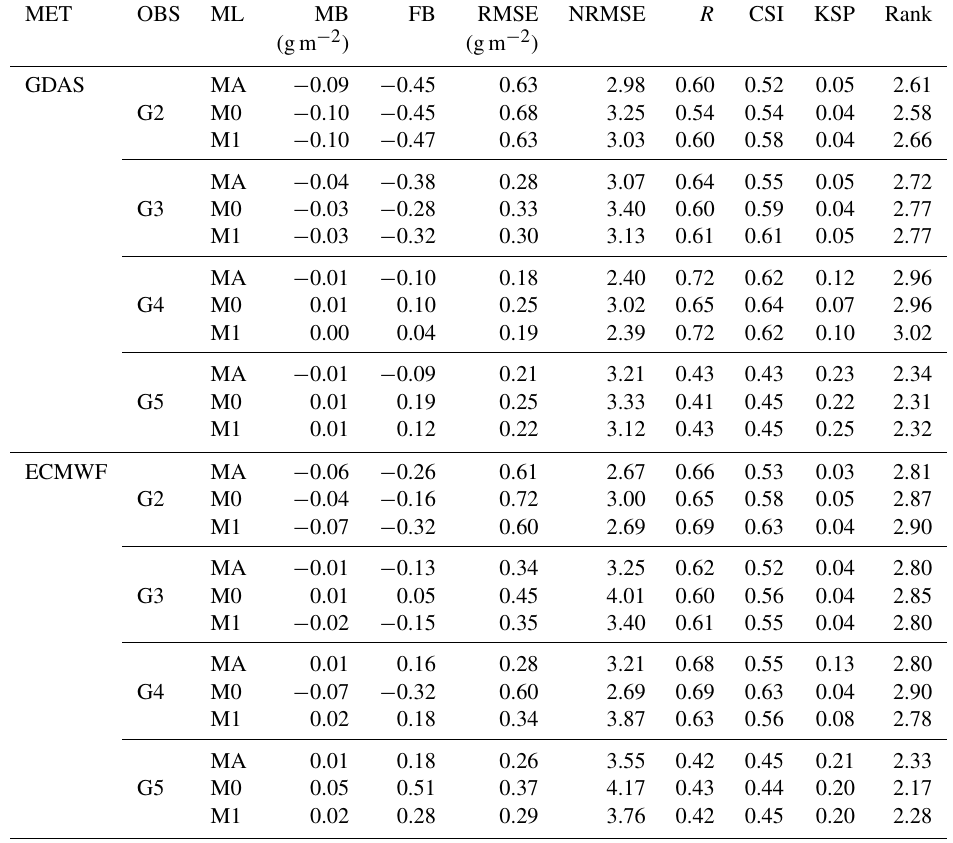
Table 3. Evaluation statistics against the G2, G3, G4, and G5 observations for cases with different ways to calculate model mass loadings. G1 and G2 are assimilated for all cases listed here. MET is meteorological input; OBS indicates satellite observations used for evaluation; ML is mass loading; MA is integrating from the surface to the cloud top; M0 is calculated for a single layer where the cloud top height resides; M1 is integrating over three layers centered at the cloud top layer; MB is the mean bias; FB is the fractional bias; RMSE is the root mean square error; NRMSE is normalized RMSE; R is the Pearson correlation coefficient; CSI is the critical success index; and KSP is the Kolmogorov–Smirnov parameter. Rank is defined in Eq.